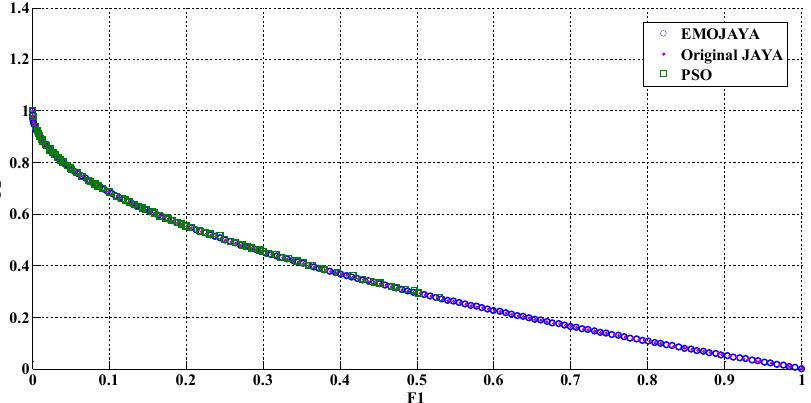
Figure 3. Comparison of the Pareto front from the EMOJAYA, JAYA and PSO (Test Function 2). -Test Function 3: The third test function is [39]: Minimize